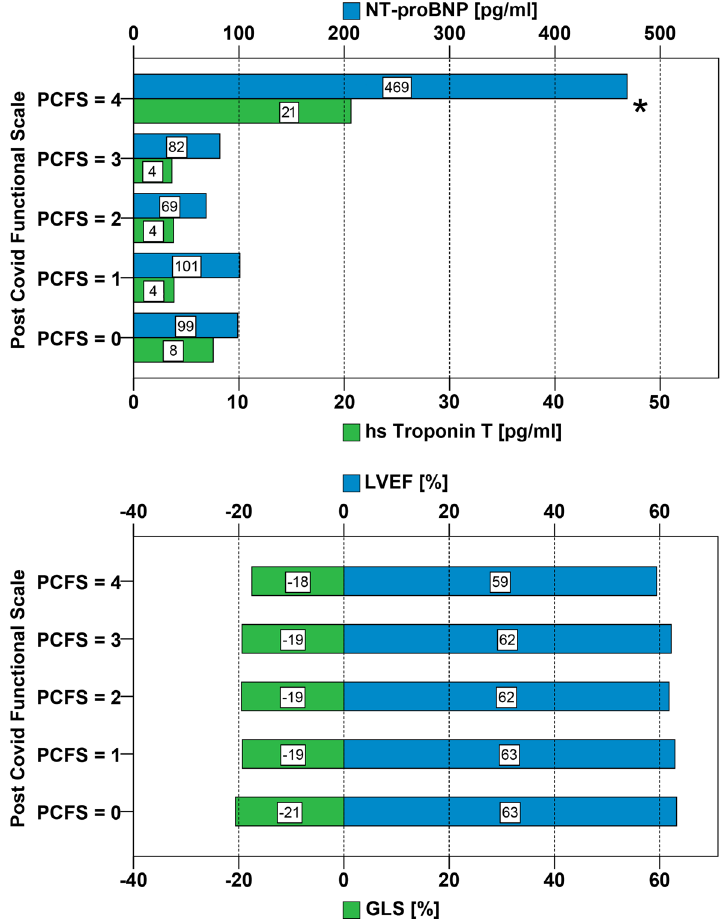
Figure 2. Cardiac biomarkers, echocardiographic parameters and Post-COVID-Functional-Scale. Upper panel: Mean serum concentrations of high sensitive troponin T and N-terminal-pro brain natriuretic peptide stratified by the five point PCFS (* P < 0.001). Lower panel: Mean measurements of LVEF and GLS stratified by PCFS ( P < 0.001*). PCFS = Post COVID Functional Scale, hs troponin T = high sensitive troponin T; NT-proBNP = N-terminal pro brain natriuretic peptide; LVEF = left ventricular ejection fraction; GLS = global longitudinal